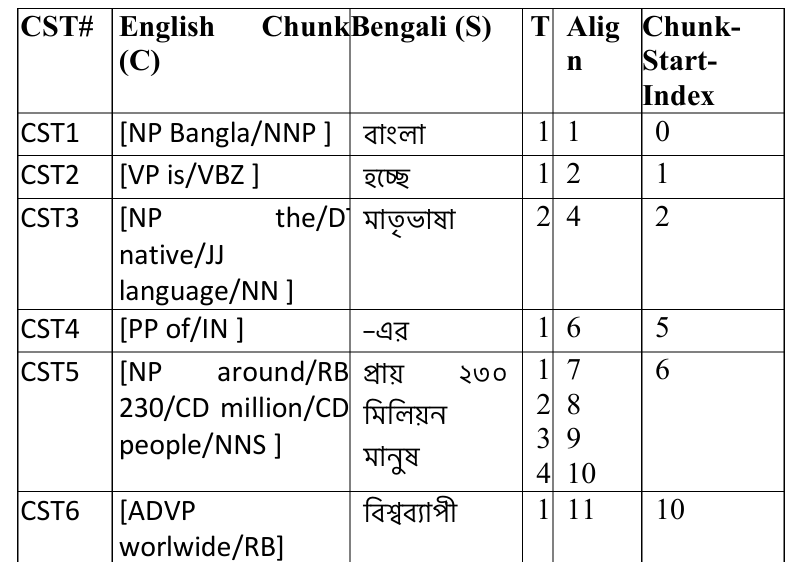
Table 2 Example of initial